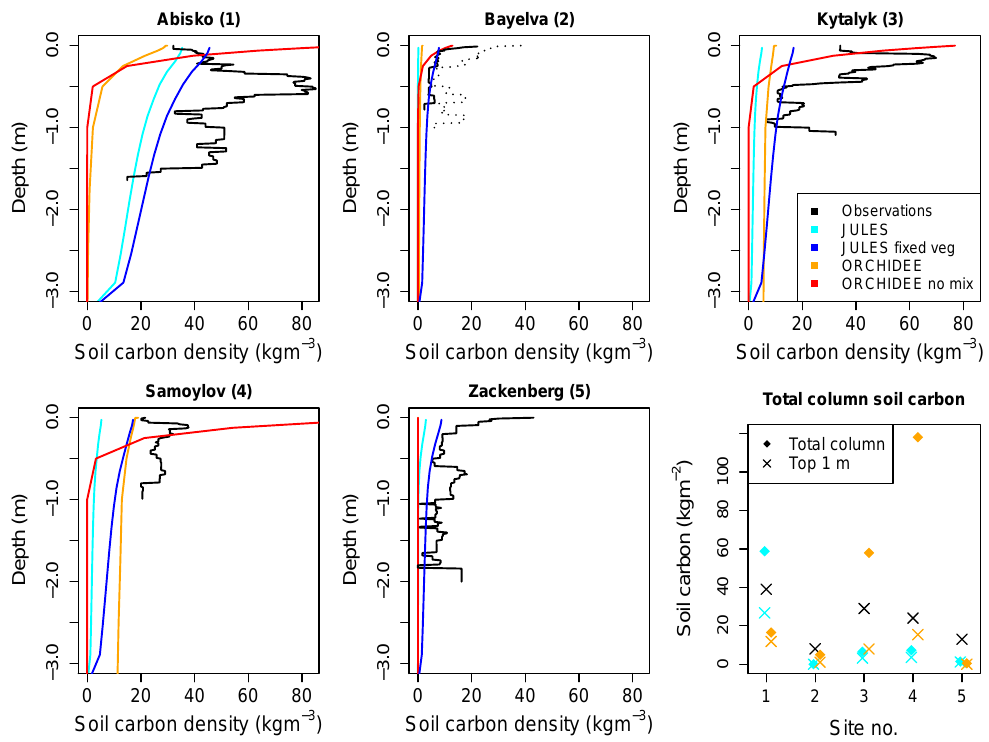
Figure 5. Profile of soil carbon at each site (kgm − 3 ). Observations and two of the models (ORCHIDEE and JULES) are shown, as these models have a vertically resolved soil carbon profile. Dotted and solid lines in the second panel (Bayelva) show two different land cover types in the vicinity of the site (solid: barren ground; dotted: sparse shrub–moss tundra.) Note that site numbers in the last panel are given in the headings of the preceding